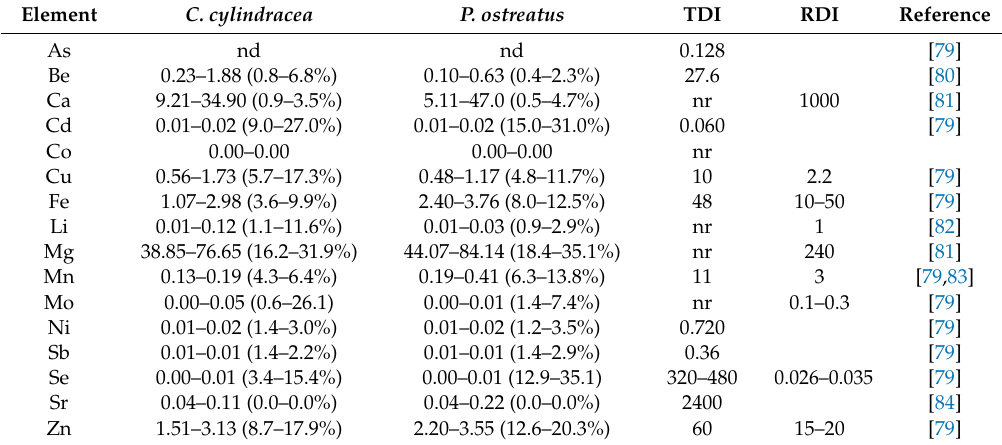
Table 3. Elements’ estimated daily intake (EDI, mg · kg − 1 · d − 1 ) and percent coverage of upper tolerable or recommended level of each element’s intake (in parentheses) through the consumption of one serving (calculated as 300 g f.w. corresponding to 30 g d.w.) of C. cylindracea and P. ostreatus